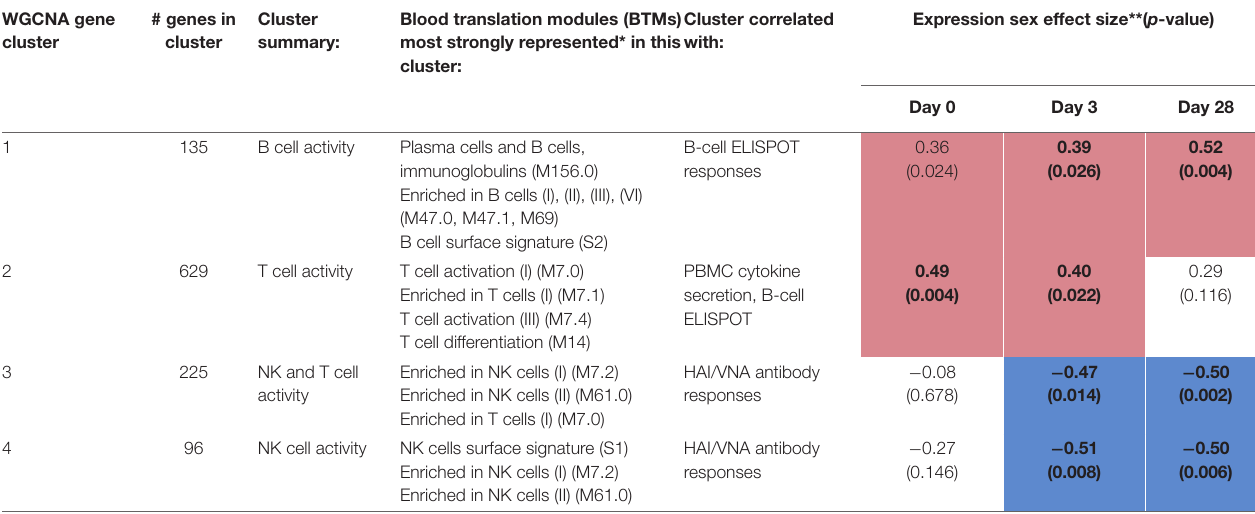
TABLE 1 | Sex differences are found in PBMC expression of gene clusters related to immune cell activity, including CD4 + T cell, B cell, and NK cell activity. WGCNA gene